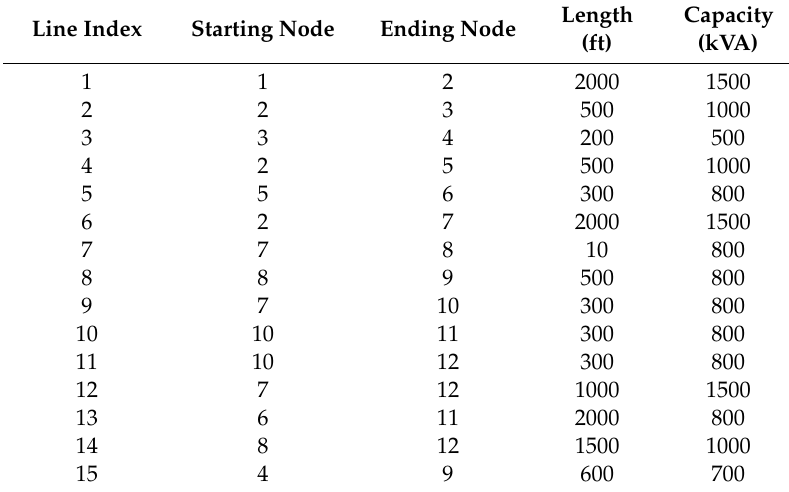
Table 1. Lines parameters of IEEE 13-node network.